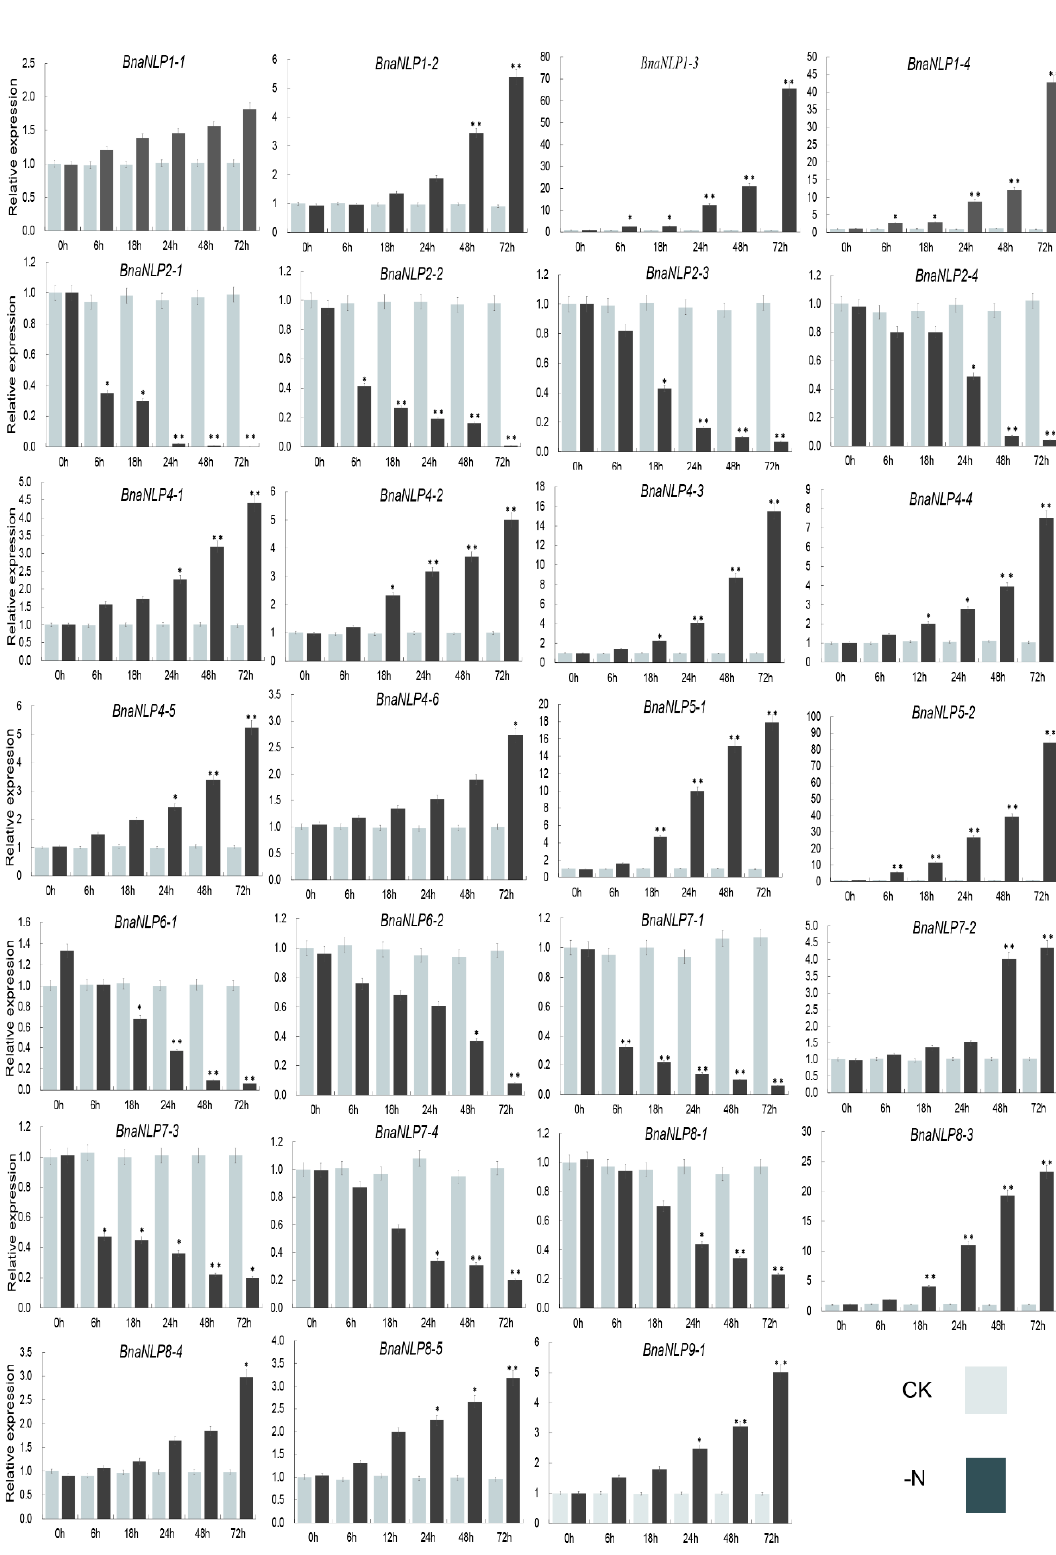
Figure 7. Expression profiles of BnaNLP genes in SRs under normal and nitrogen deficient conditions. Relative expression levels of BnaNLP genes were determined by RT-qPCR. SRs were collected under normal growth and nitrogen deficient conditions at 0, 6, 12, 24, 48, and 72 h after treatment. * represents the significant level, ** represents the extremely significant level.